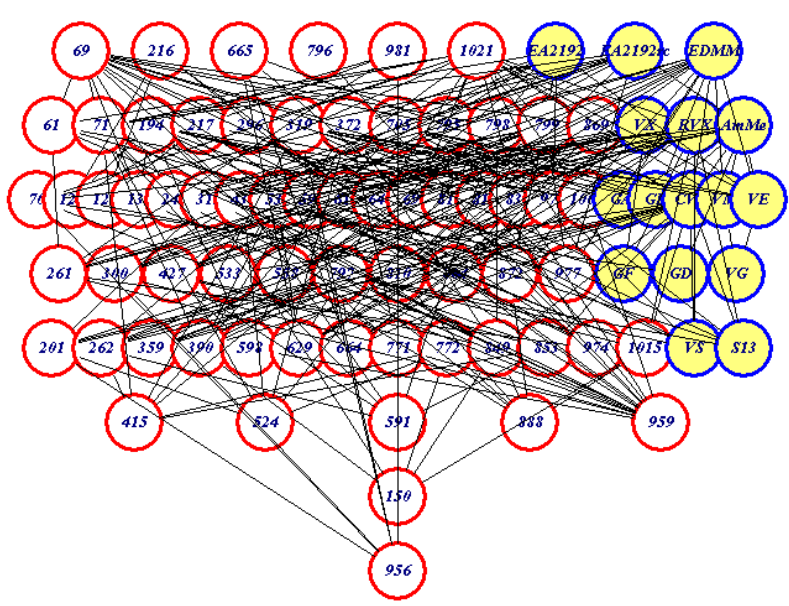
Figure 3. Hasse diagram displaying the aqueous persistence of the 65 OP insecticides (white/red) and 16 nerve agent (yellow/blue), The numbers corresponds to the numbering of the OP insecticides in the FADINAP database